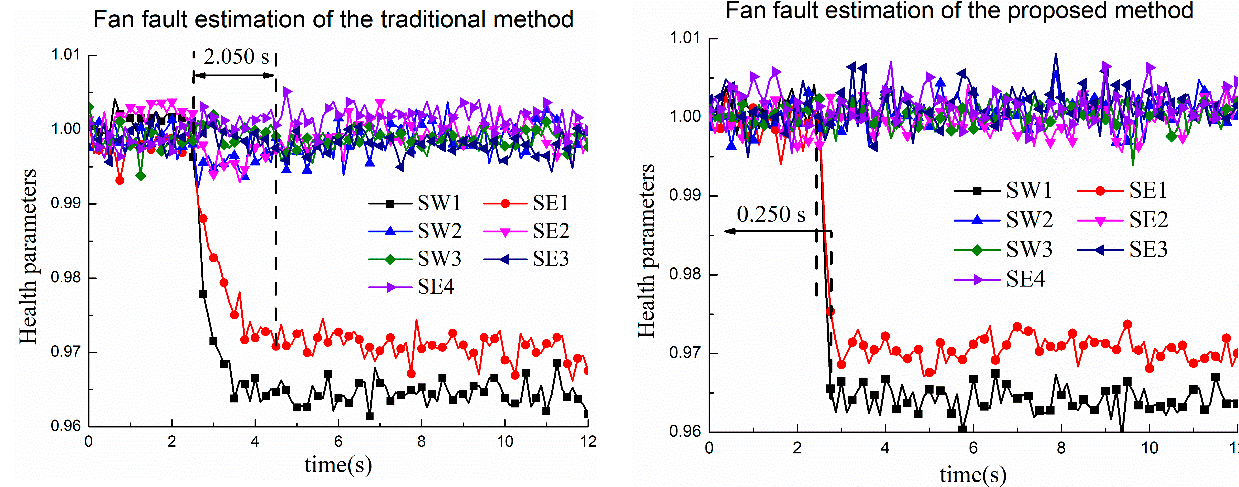
Figure 11. The comparison of the traditional and the proposed methods in Case 1.